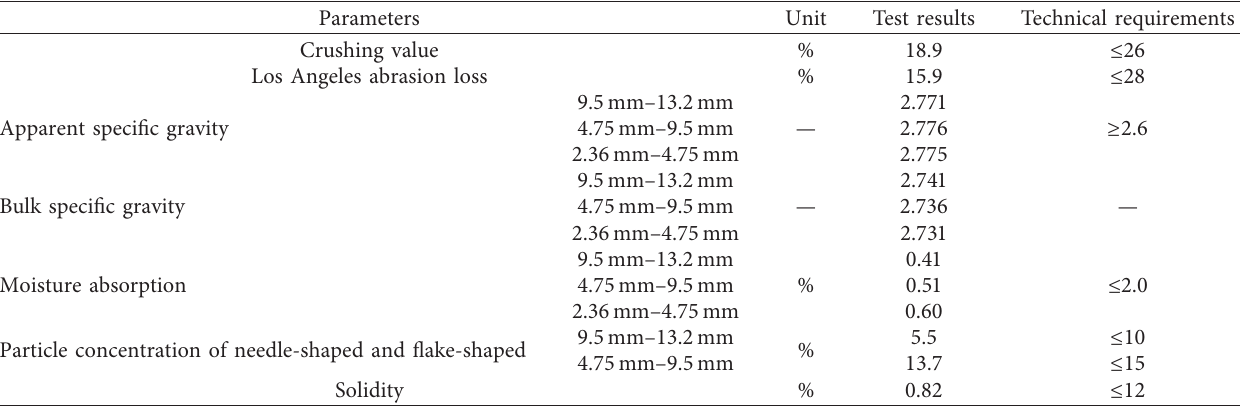
Table 4: Properties of aggregates.